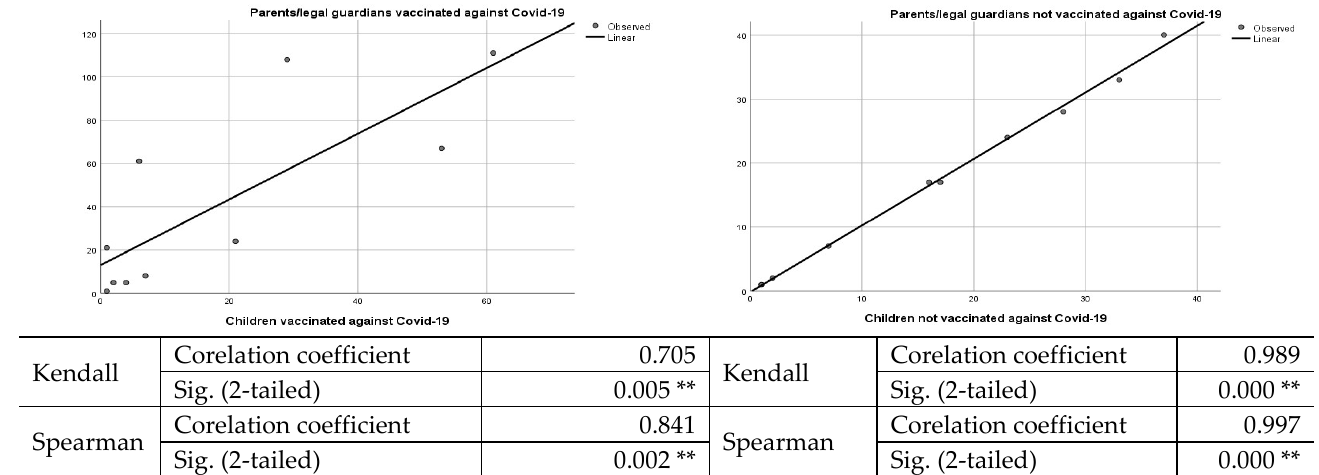
Figure 1. Correlation between parents/legal guardians and children vaccinated/not vaccinated against COVID-19. **. Correlation is significant at the 0.01 level (2-tailed). For children who have not reached the minimum age to be vaccinated or the vaccine is not yet available for their age, 77.8% of vaccinated parents/guardians responded that they will vaccinate their children when possible. In the case of unvaccinated parents/guardians, only 3.5% stated that they would vaccinate their children against COVID-19 when